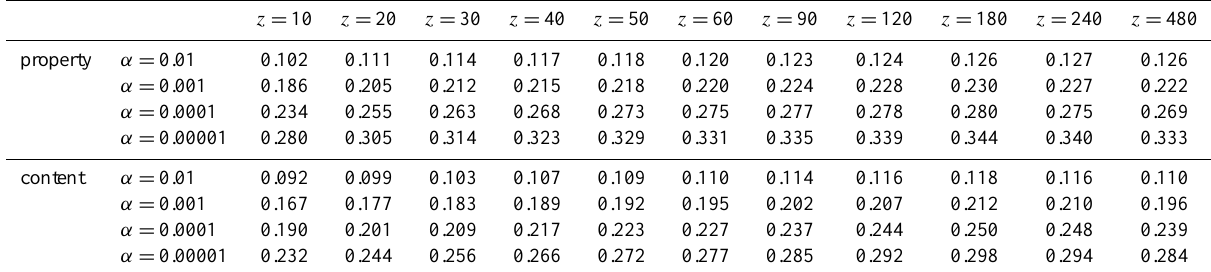
Table 6. Rainfall thresholds: rainfall intensity in mm h − 1 for time window z at which probability of a damage event θ = 0 . 5. z = 10 z = 20 z = 30 z = 40 z = 50 z = 60 z = 90 z = 120 z = 180 z = 240 z = 480 property α = 0.01 52.2 α = 0.0001 content